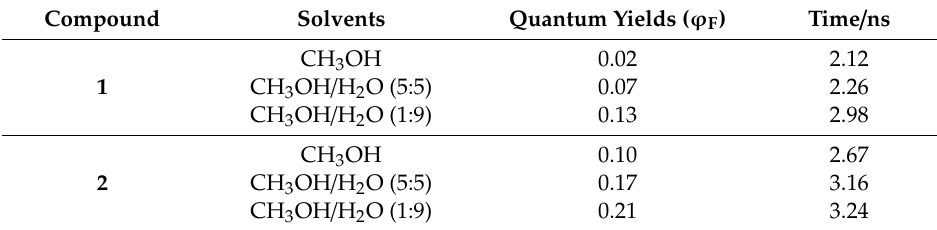
Table 1. The fluorescence quantum yield and fluorescence lifetime of compounds 1 and 2 . Compound Solvents Quantum Yields ( ϕ F